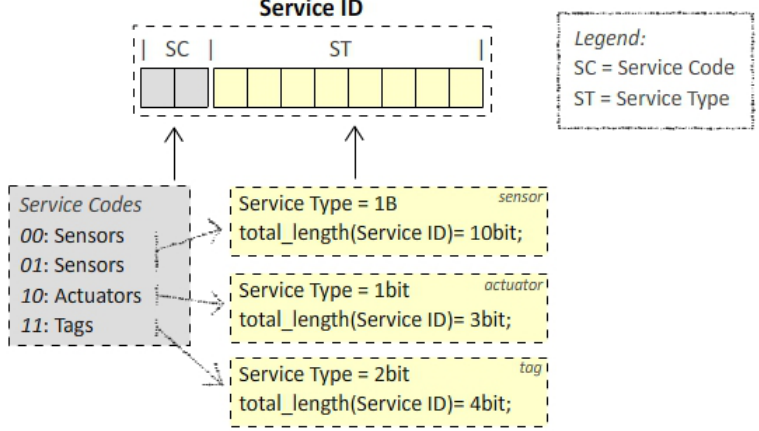
Figure 10. Rough Service ID